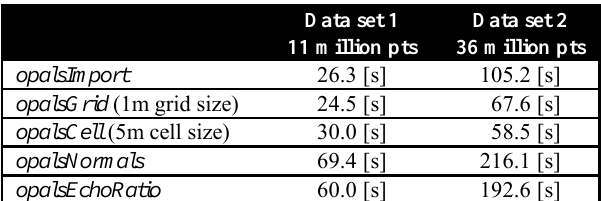
Processing times of different OPALS modules on